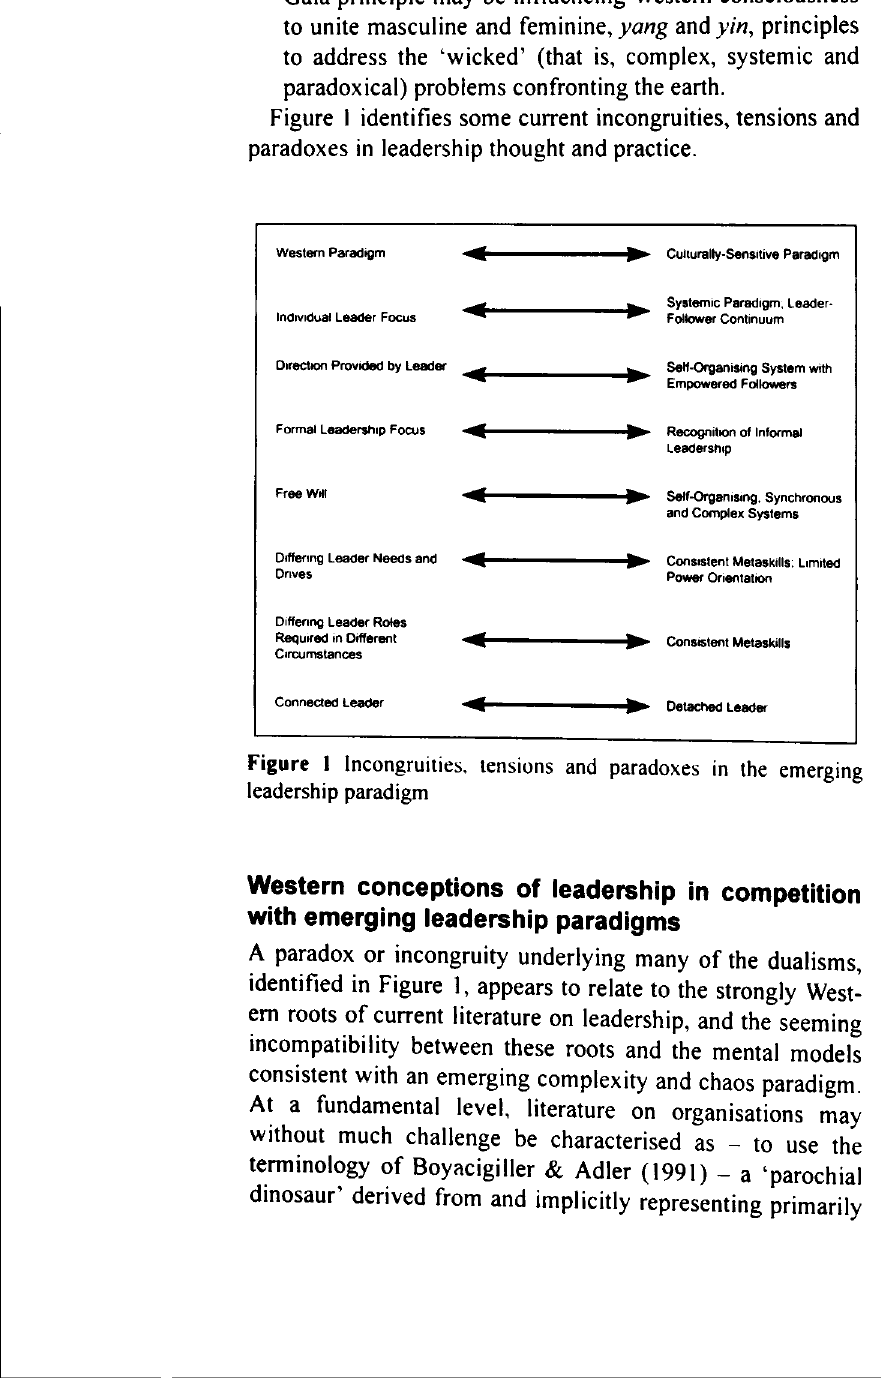
~estern c~nceptions of leadership in competition with emerging leadership